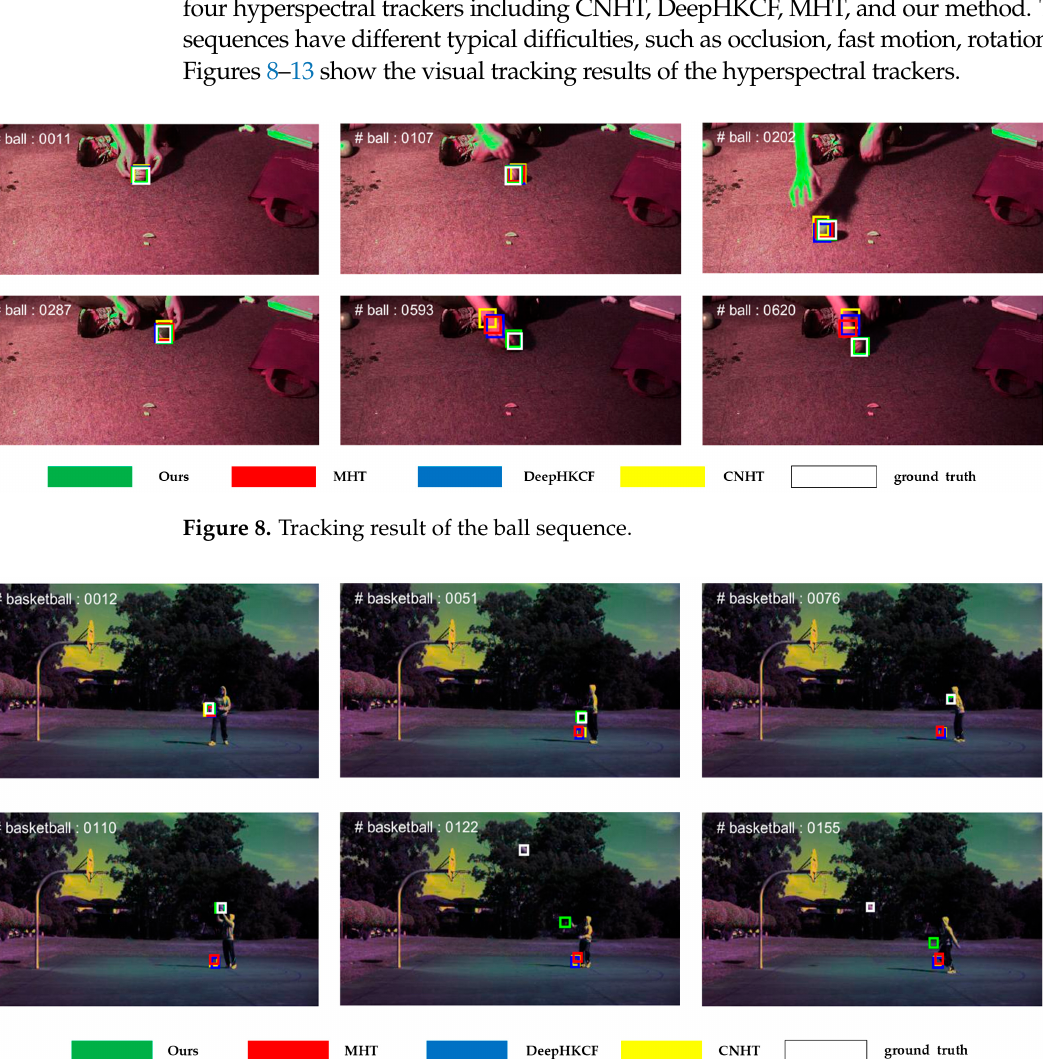
Figure 9. Tracking result of the basketball sequence.